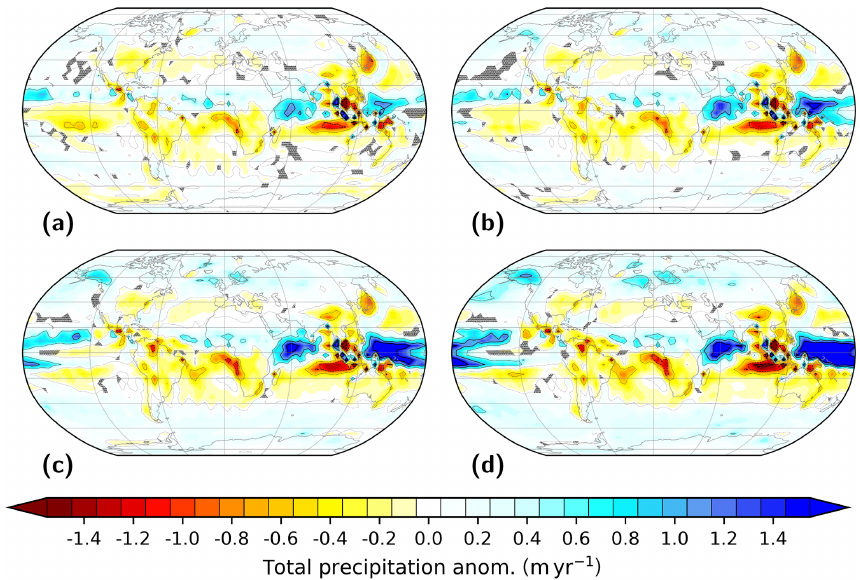
Figure 21. Sensitivity of annual mean total precipitation to variations in the volume mixing ratio of carbon dioxide for mid-Pliocene paleogeography. Shown are anomalies with respect to pre-industrial (E280) for simulations (a) Eoi280, (b) Eoi350, (c) Eoi450, and (d) Eoi560. Contours illustrate isolines of − 1 . 5myr − 1 (dashed), − 1 . 0myr − 1 (dashed, thin), 0.0myr − 1 (dotted, thin), 0.5myr − 1 (solid, thin), 1.0myr − 1 (solid), and 1.5myr − 1 (solid, thick). In hatched regions the anomaly is insignificant at the 95% confidence interval